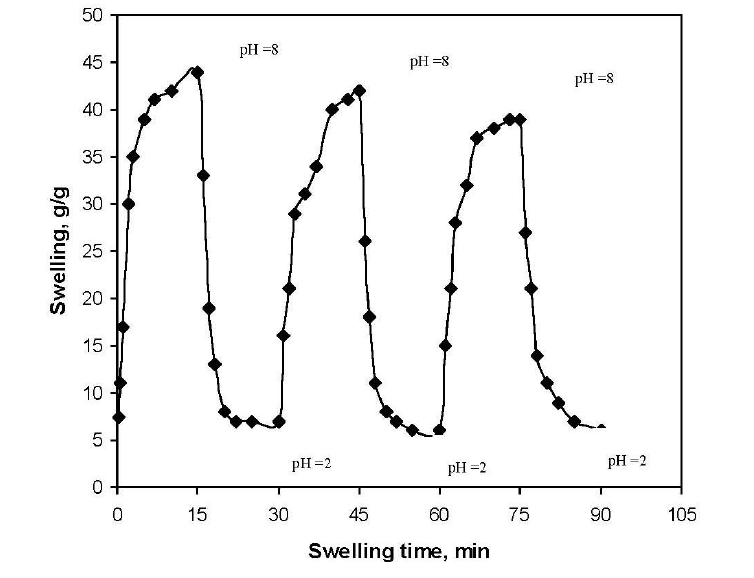
Figure 7. On-off switching behavior as reversible pulsatile swelling (pH 8.0) and deswelling (pH 2.0) of the gelatin-g-PMAA